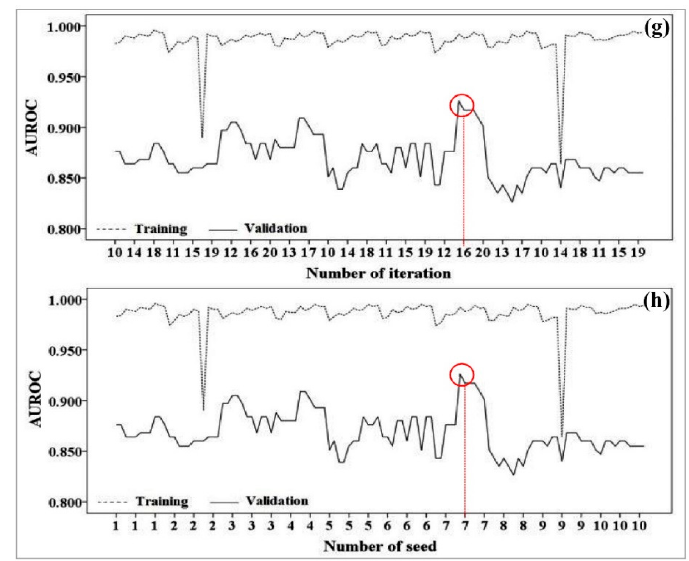
Figure 5. The trend of changes of the number of seed and iteration in the landslide modeling process: ( a ) optimum number of iteration for the combination of 60%/40% with the raster resolution of 10 m, ( b ) optimum number of seed for the combination of 60%/40% with the raster resolution of 10 m; ( c ) optimum number of iteration for the combination of 70%/30% with the raster resolution of 10 m, ( d ) optimum number of seed for the combination of 70%/30% with the raster resolution of 10 m; ( e ) optimum number of iteration for the combination of 80%/20% with the raster resolution of 20 m, ( f ) optimum number of seed for the combination of 80%/20% with the raster resolution of 20 m; ( g ) optimum number of iteration for the combination of 90%/10% with the raster resolution of 20 m, ( h ) optimum number of seed for the combination of 90%/10% with the raster resolution of 20 m.